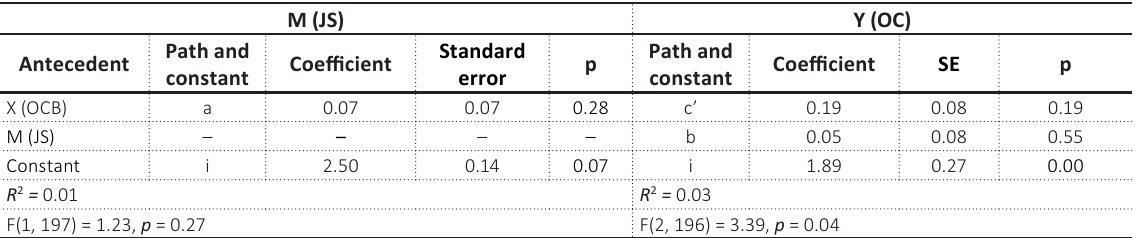
Table 2. The data showing paths and